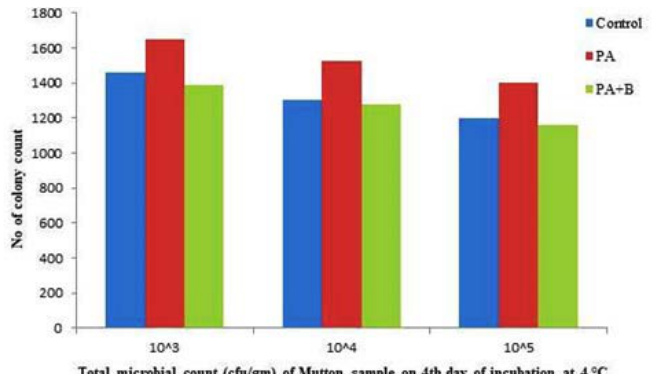
Fig. 2.9. Total microbial count of mutton meat sample treated with strain and phage on 4 th day of Incubation at 4 °C